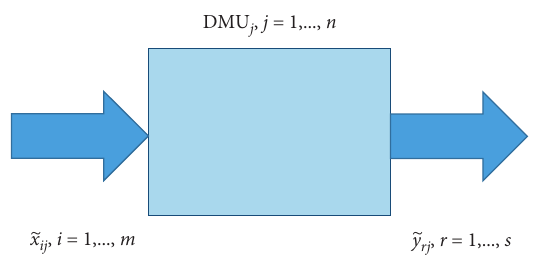
Figure 14: A DMU with m IF inputs and s IF